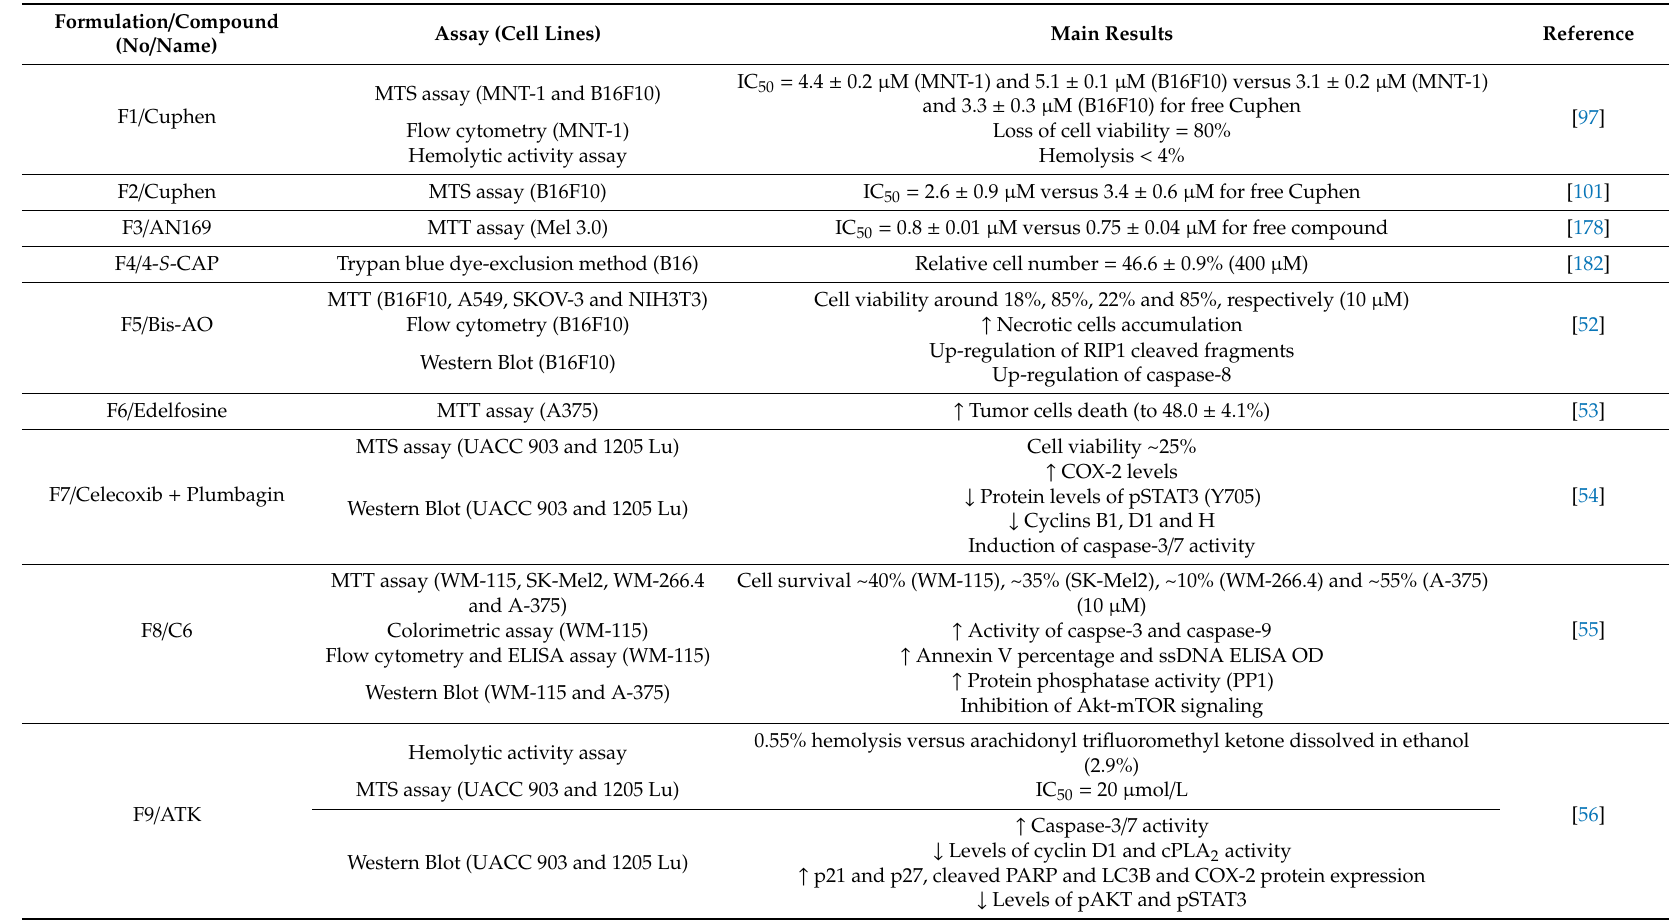
Table 4. In vitro evaluation studies of the di ff erent compound-loaded